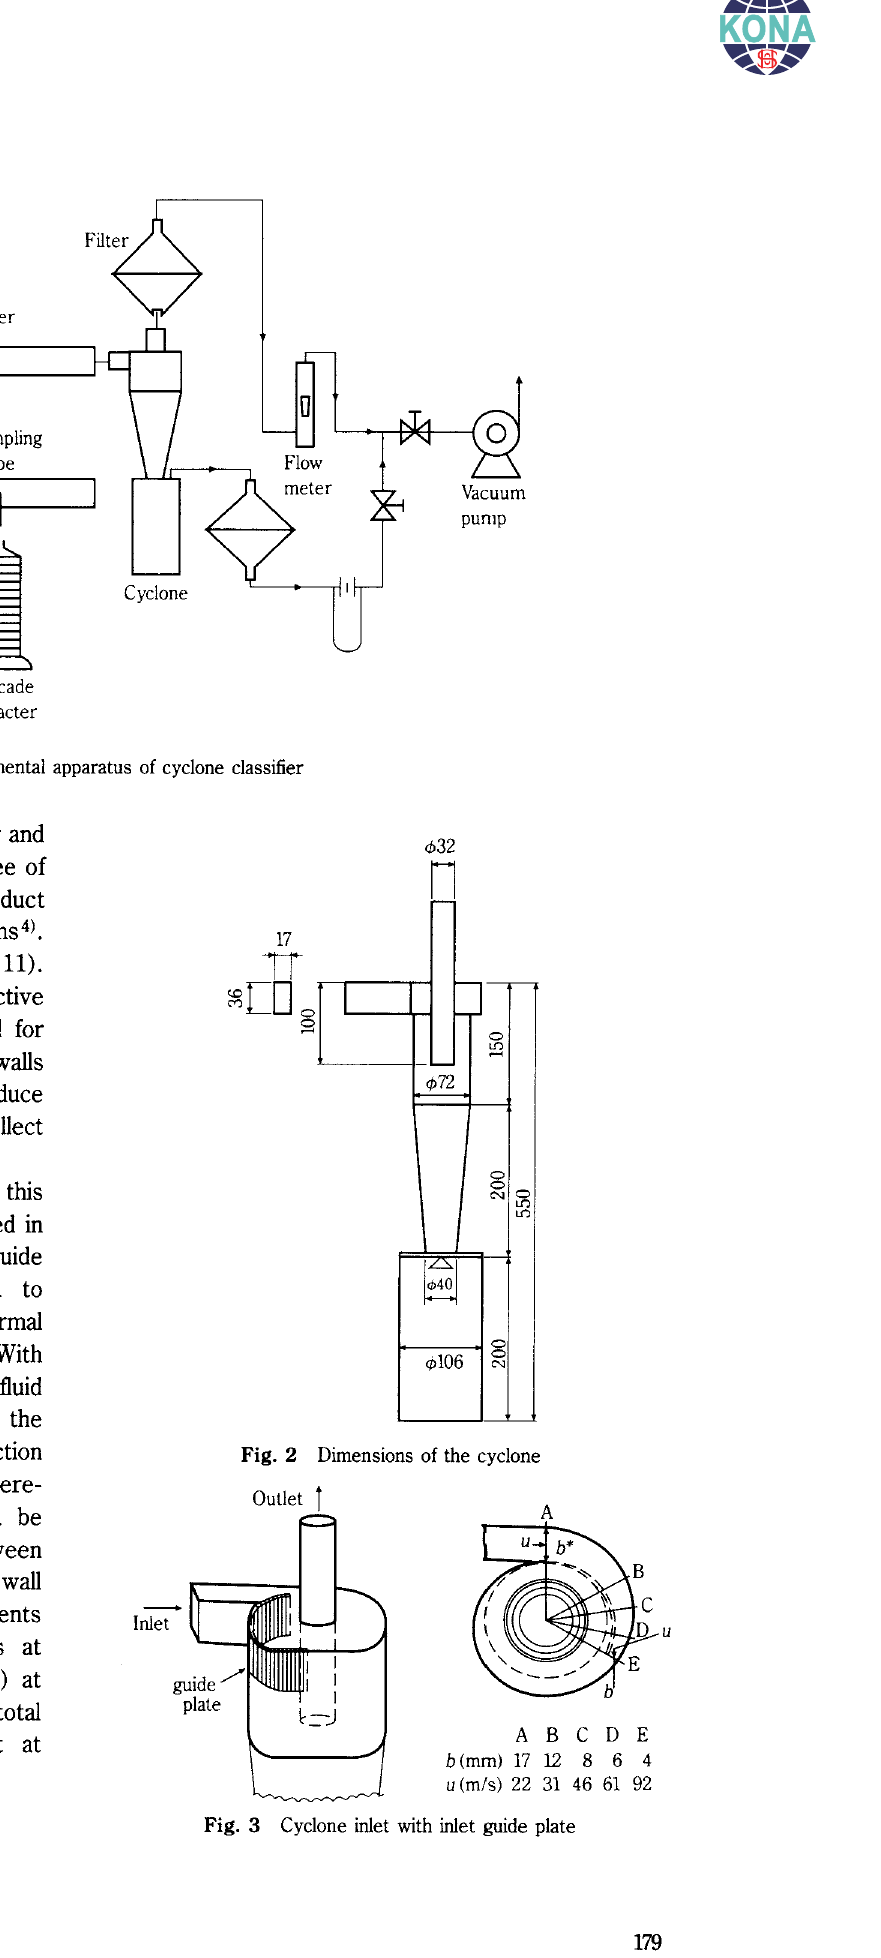
Fig. 3 Cyclone inlet with inlet guide